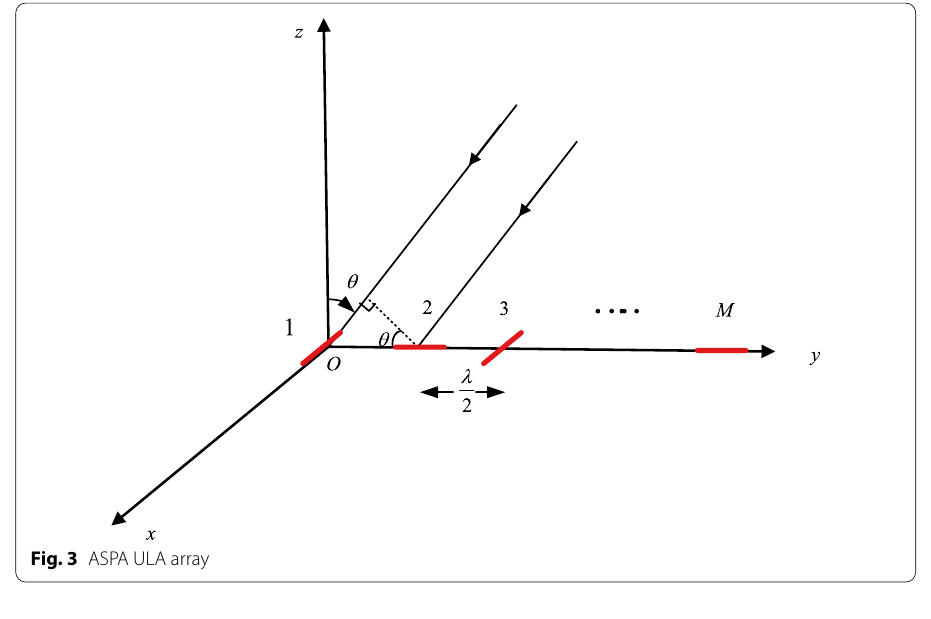
Fig. 3 ASPA ULA array